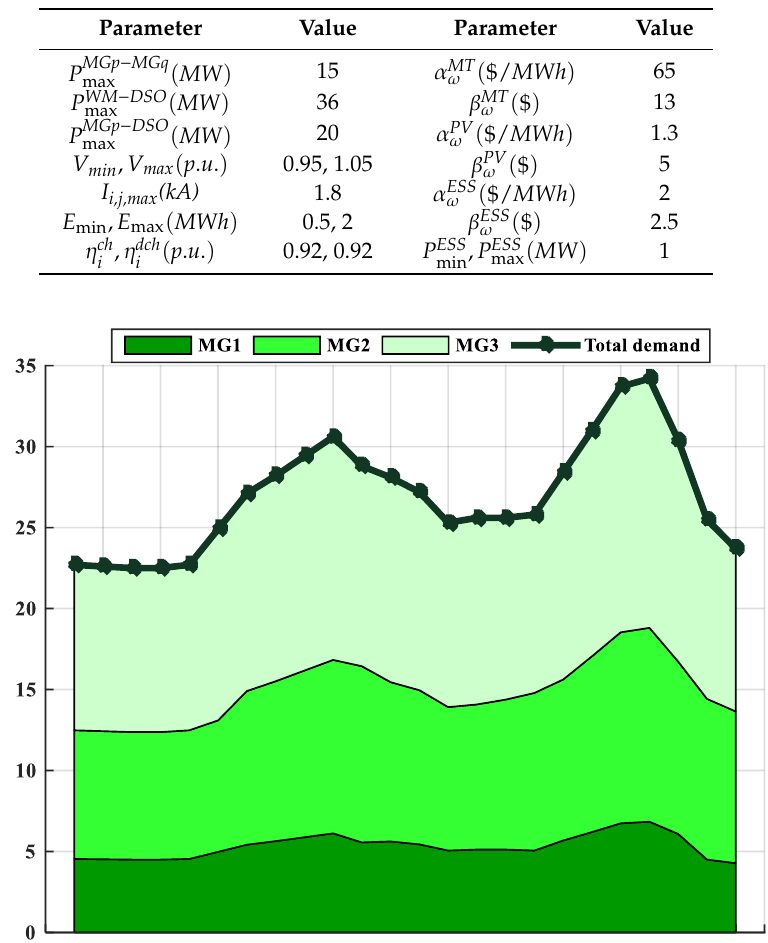
Table 1. Required technical parameters [1].